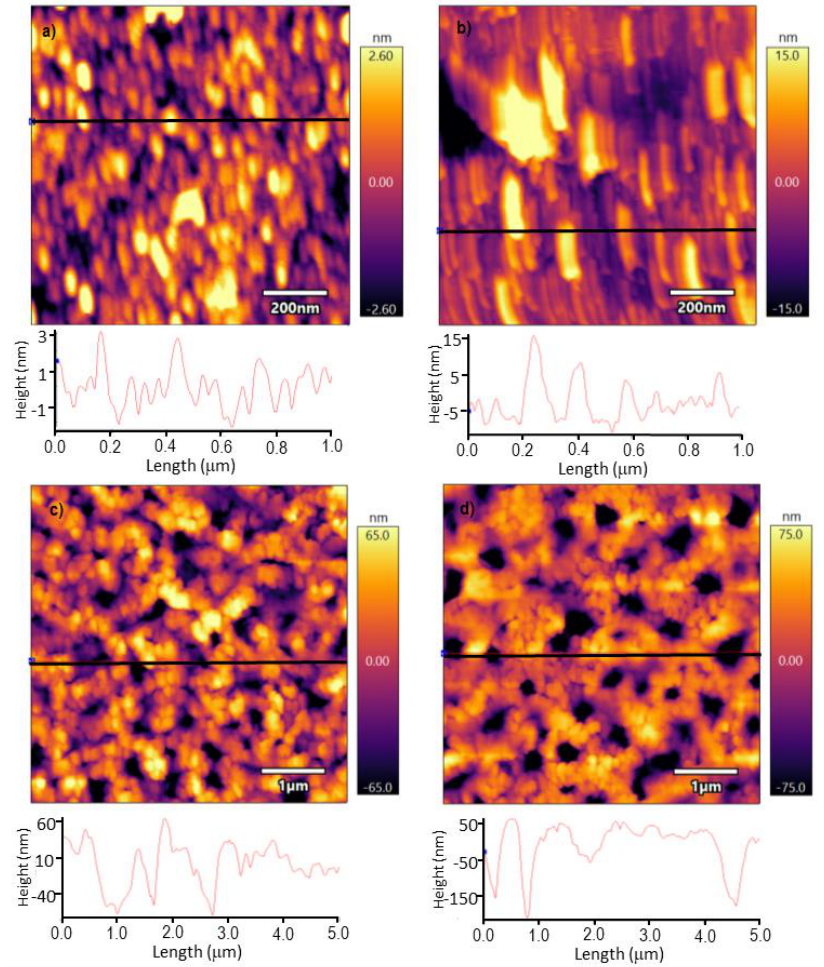
Figure 2. AFM topographic images of ( a ) [(CHI)-(CuPcS)-(CHI)-(AuNPs)] 2 , ( b ) [(CHI)-(AuNPs)-(CHI)- (CuPcS)] 2 ; ( c ) [(CHI)-(CuPcS)-(CHI)-(AuNPs)] 2 –Tyr and d ) [(CHI)-(AuNPs)-(CHI)-(CuPcS)] 2 –Tyr.